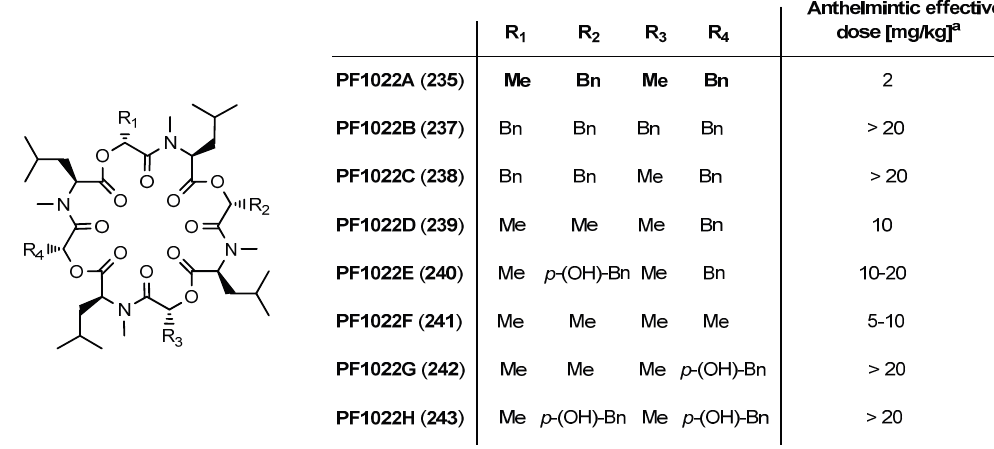
(a) >90% worm reduction against Ascaridia galli in